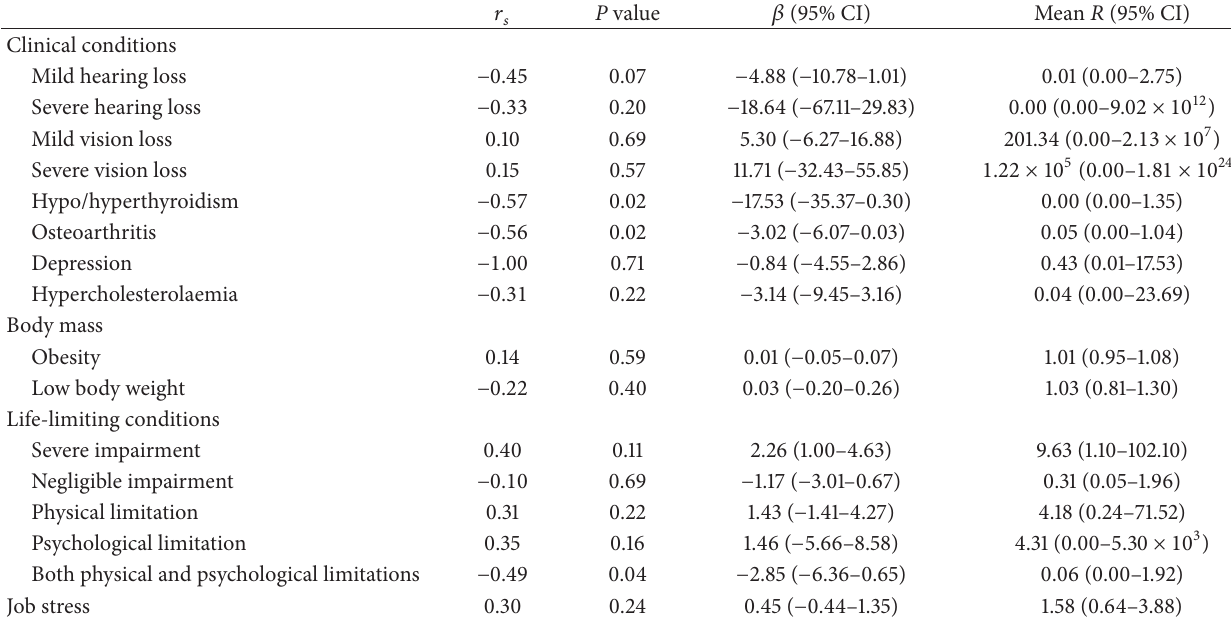
Table 2: Association analysis of the differences in migraine prevalence by the percentage of population in each region presenting a series of clinical and pathophysiological